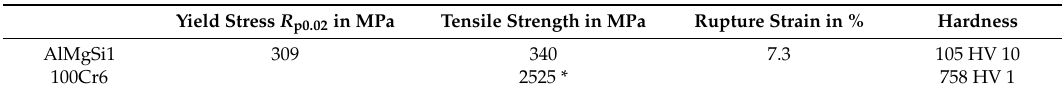
Figure 2. ( a ) Aluminum hub, forging alloy AlMgSi1; ( b ) steel knurled shaft bearing steel 100Cr6; and ( c ) experimental parameters. Table 2. Material